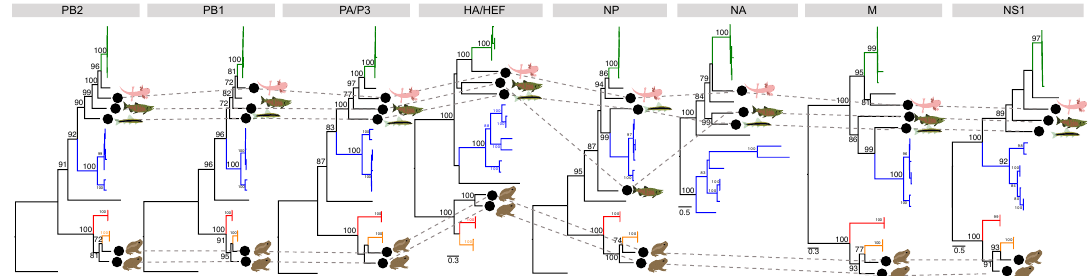
Figure 3. Phylogenetic trees for segments in cases where complete coding genomes could be recovered. Maximum likelihood trees for each segment ordered by (segment) size. Lineages are coloured by influenza virus, in which IAV, IBV, ICV, IDV are coloured blue, green, red and orange, respectively. Viruses identified in this study are denoted by a black circle and pictogram of the host species of the library. The phylogenetic position of each virus is traced across the trees with grey dashed lines. ICV, IDV, cane toad and chorus frog influenza-like viruses do not have an NA segment. The scale bar for each tree indicates the number of amino acid substitutions per site. Where possible, the trees are rooted using the hagfish influenza virus (PB2, PB1, PA / P3, NP). The HA / HEF, M and NS trees were midpoint rooted.